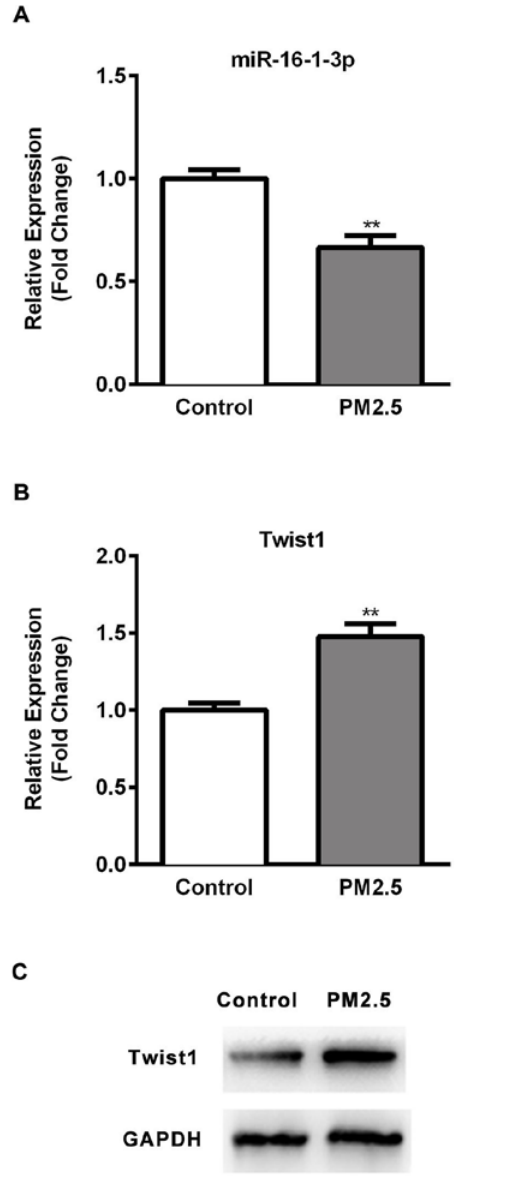
Figure 5: Effect of PM2.5 on the expression of miR-16-1-3p and Twist1 in SMMC-7721 cells (A) Expression of miR-16-1-3p in PM2.5 treated cells and un-treated cells was detected using RT-qPCR. (B) Expression of Twist1 in PM2.5 treated cells and un-treated cells was detected using RT-qPCR. (C) Expression of Twist1 in PM2.5 treated cells and un-treated cells was detected using WB. Results were normalized with the level of U6 control. Data are mean ± SD. *, p < 0.05, **, p < 0.01.